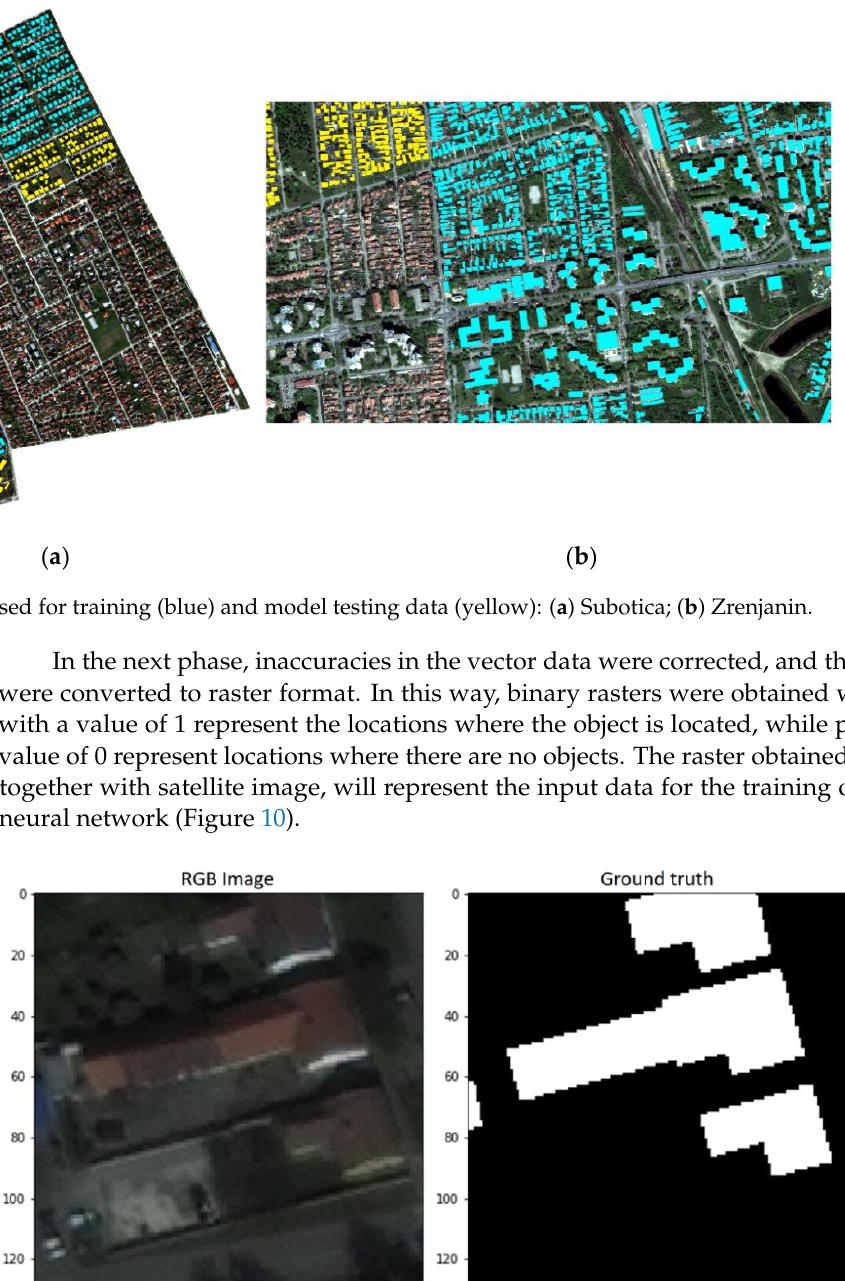
Figure 10. An example of a pair of input data used for training: ( a ) Subotica; ( b ) Zrenjanin.